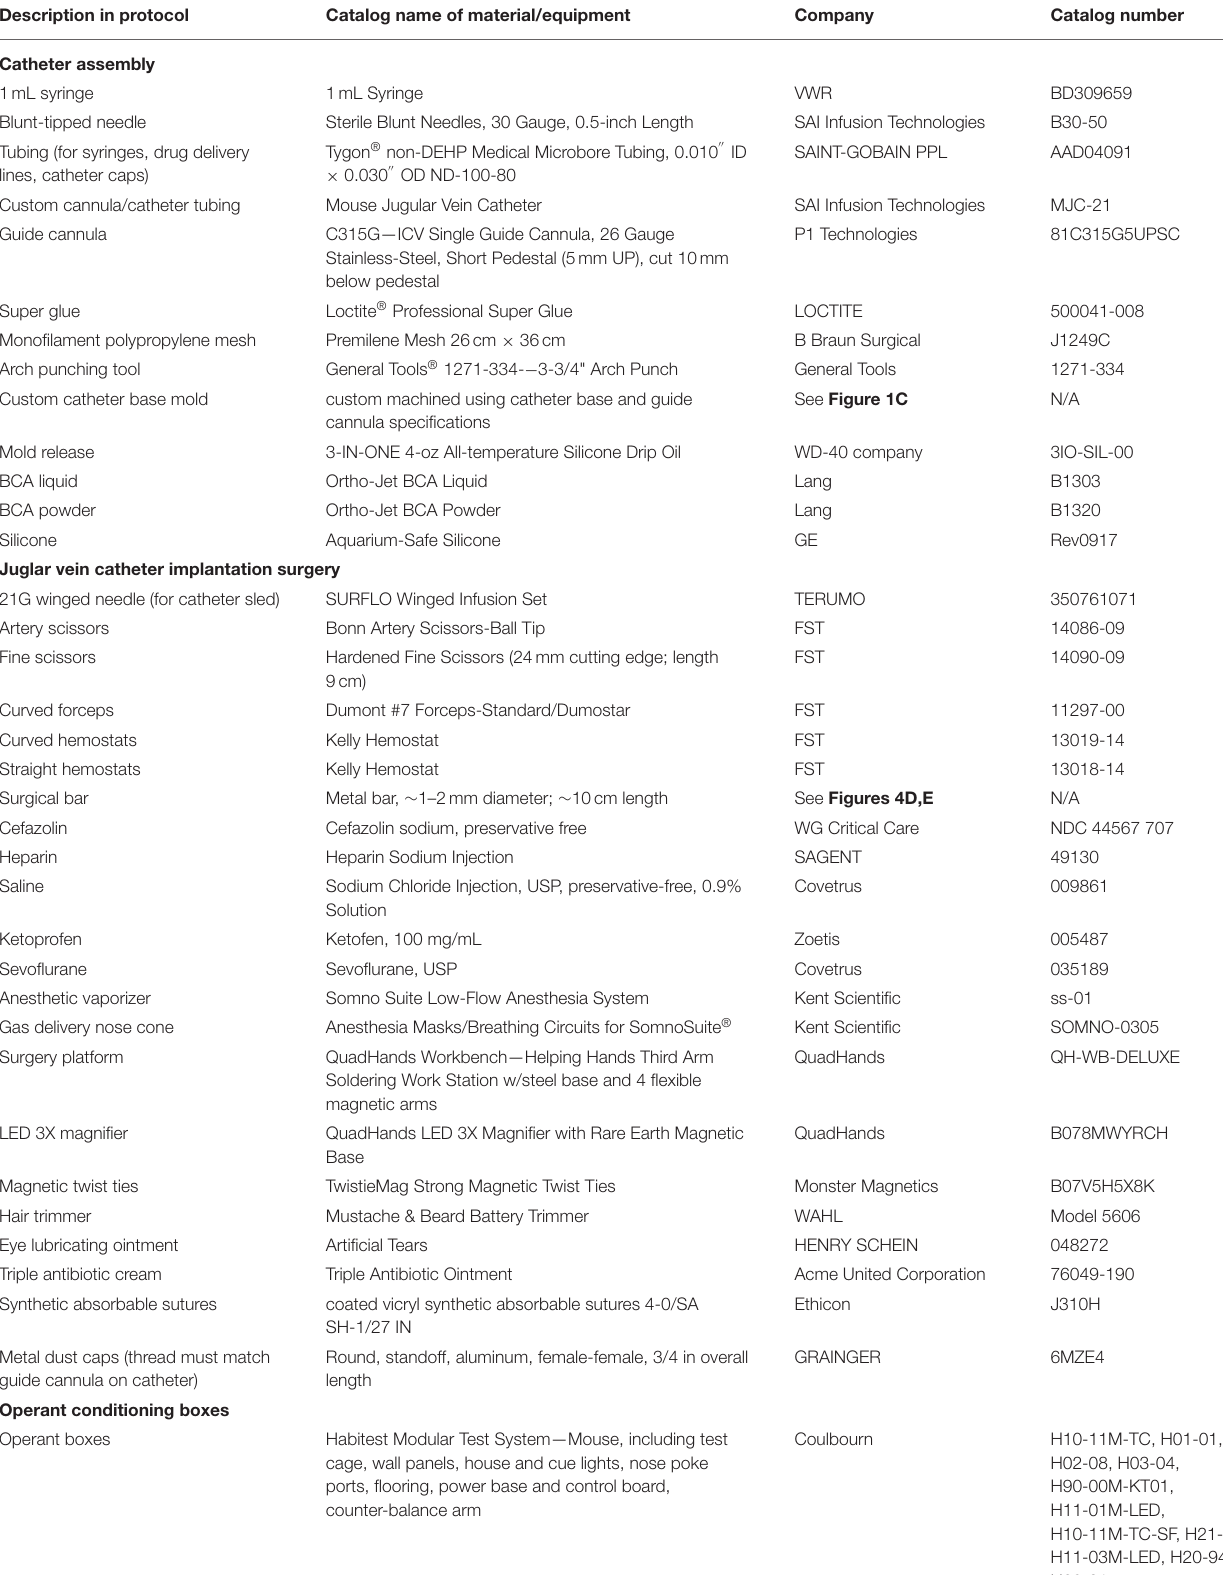
TABLE 3 | Description of materials used in the